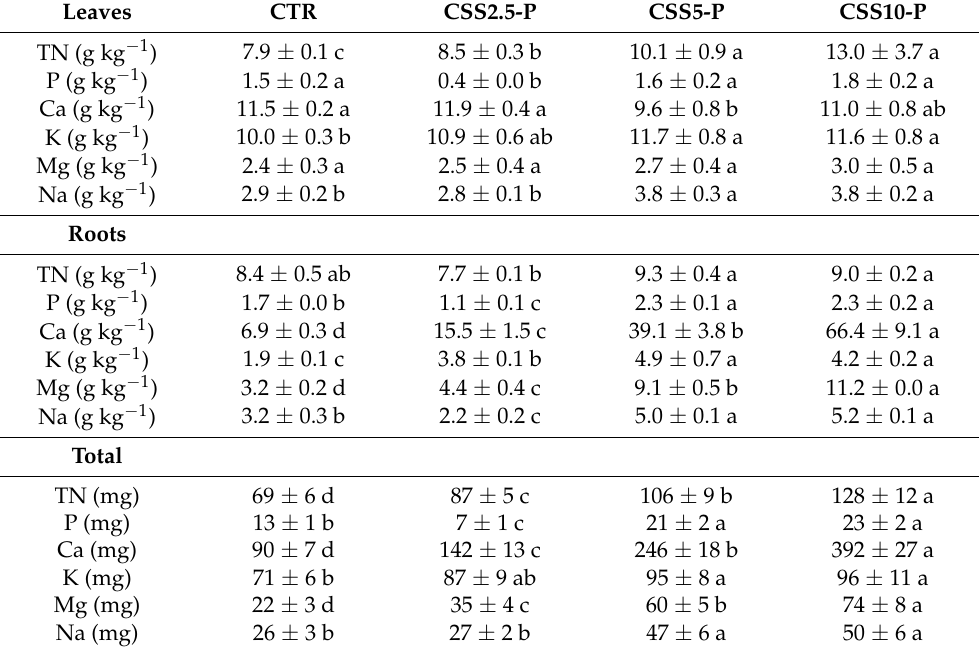
Table 5. Macronutrient concentration in leaves and roots after treatment with CSSs at different doses and total content in total plant tissue.